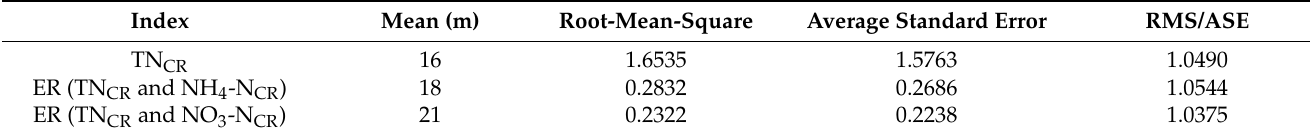
Table 4. Accuracy of three raster